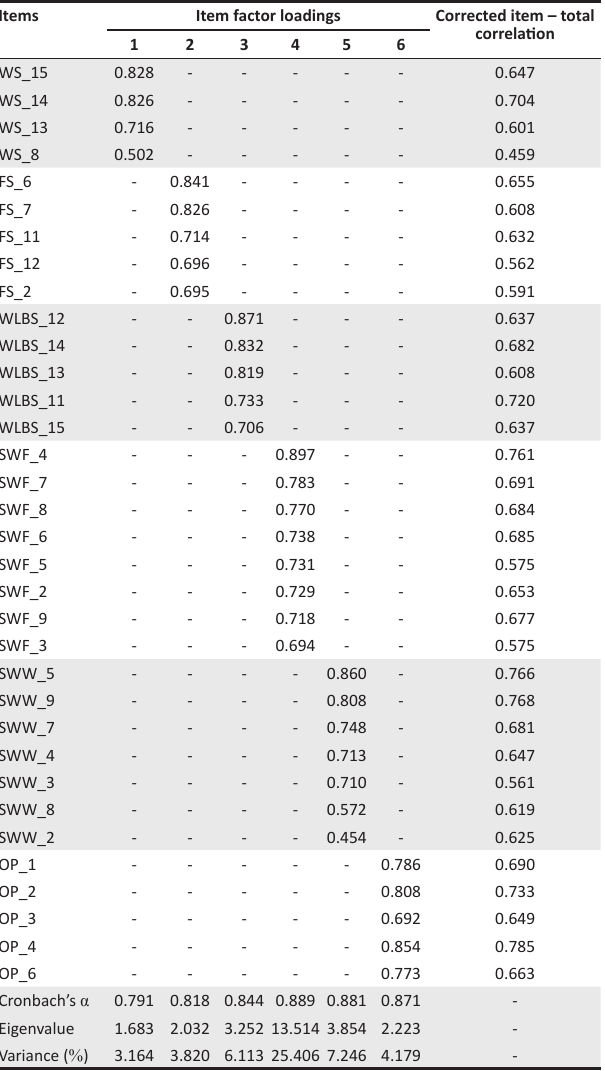
TABLE 1: Exploratory factor analysis of measuring instruments. Items Item factor